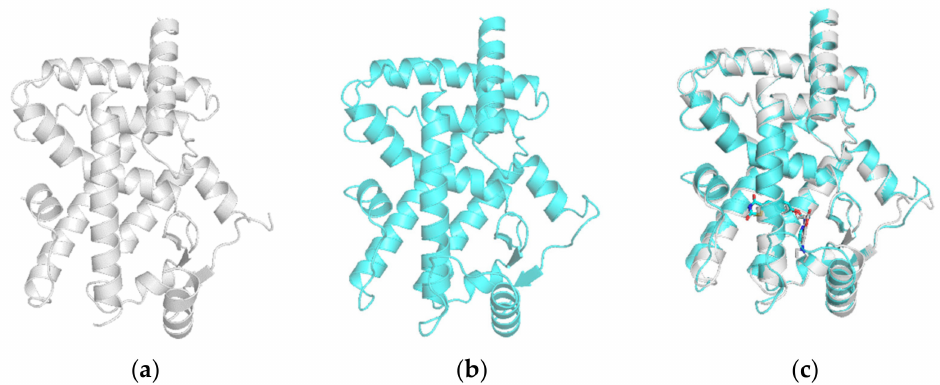
Figure 5. ( a ) The overall crystal structure of the 2 /PPAR γ -LBD complex (PDB code: 7EFQ). ( b ) The overall crystal structure of the rosiglitazone/PPAR γ -LBD complex (PDB code: 2PRG). ( c ) Comparison of the overall crystal structure of the 2 /PPAR γ -LBD complex with the rosiglitazone/PPAR γ -LBD complex.